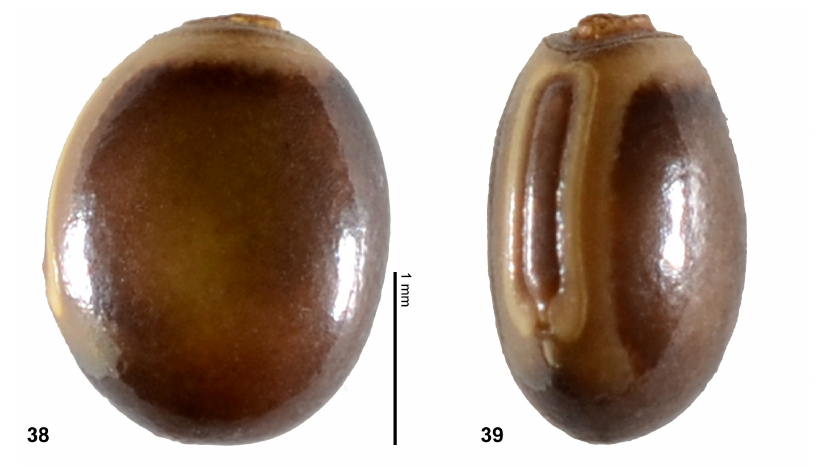
Figs 38–39. Lobolibethra pozuzoae sp. nov. 38 . Egg, PT: lateral view (FH, 0631-E); 39 . Egg, PT: dorsal view (FH,